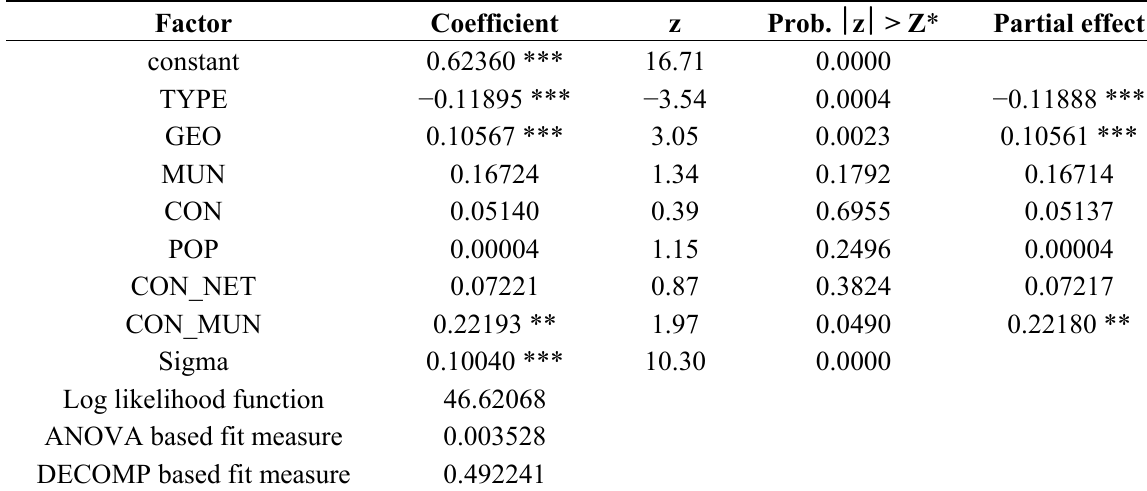
Table 7. Two-limit Tobit estimates of the stage 2 analysis of water provision operators on factors affecting